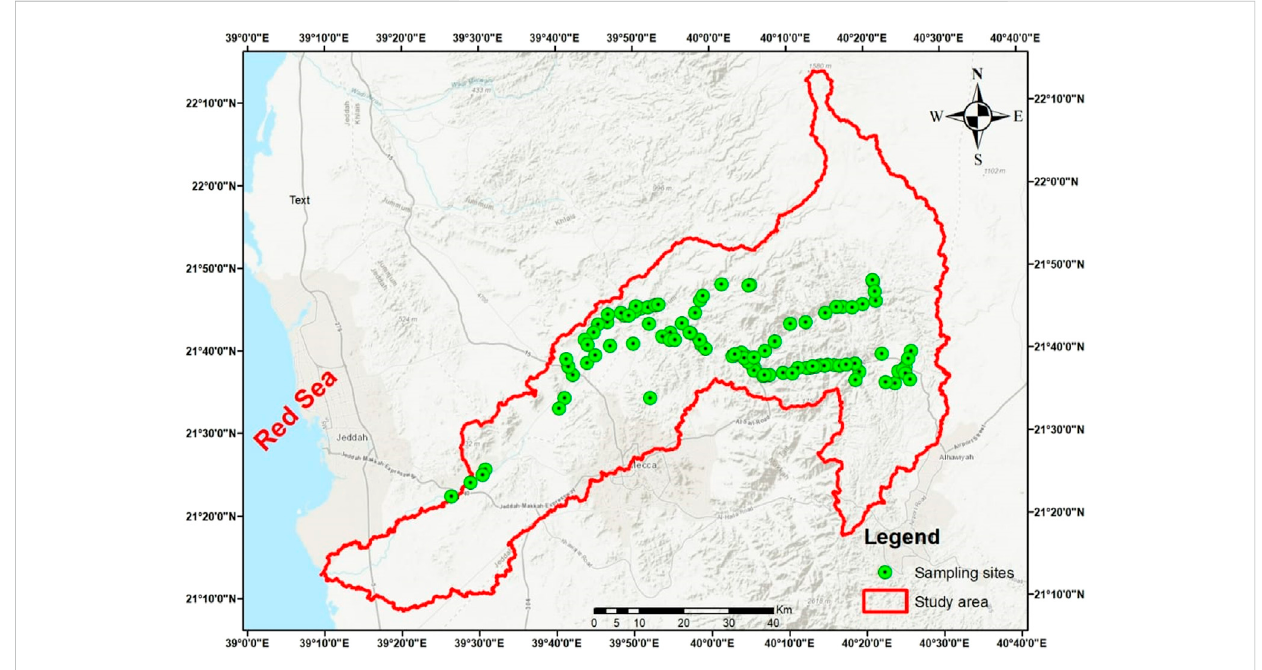
FIGURE 1 Geographical location of Wadi Fatimah, KSA, and sampling locations.